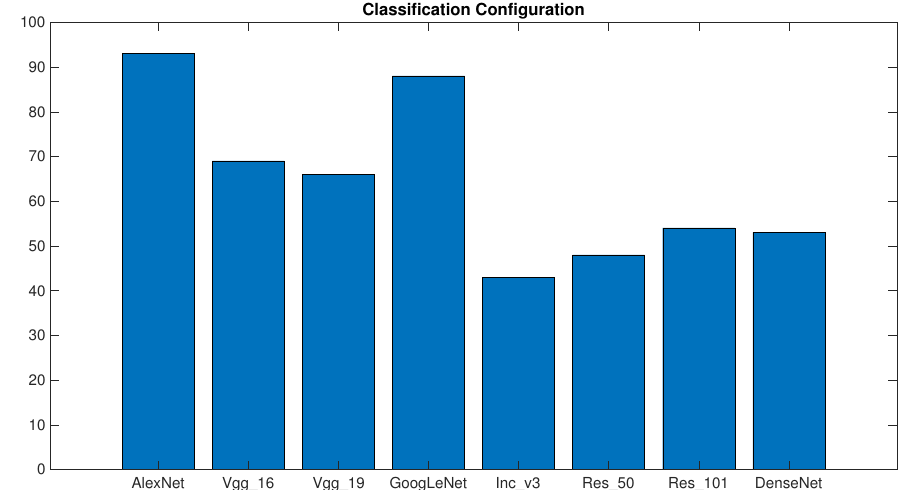
Figure 8. Consistency evaluation of the eight architectures under the classifier configuration; the plot gives the architectures on the x -axis and the corresponding total amount of collected points on the y